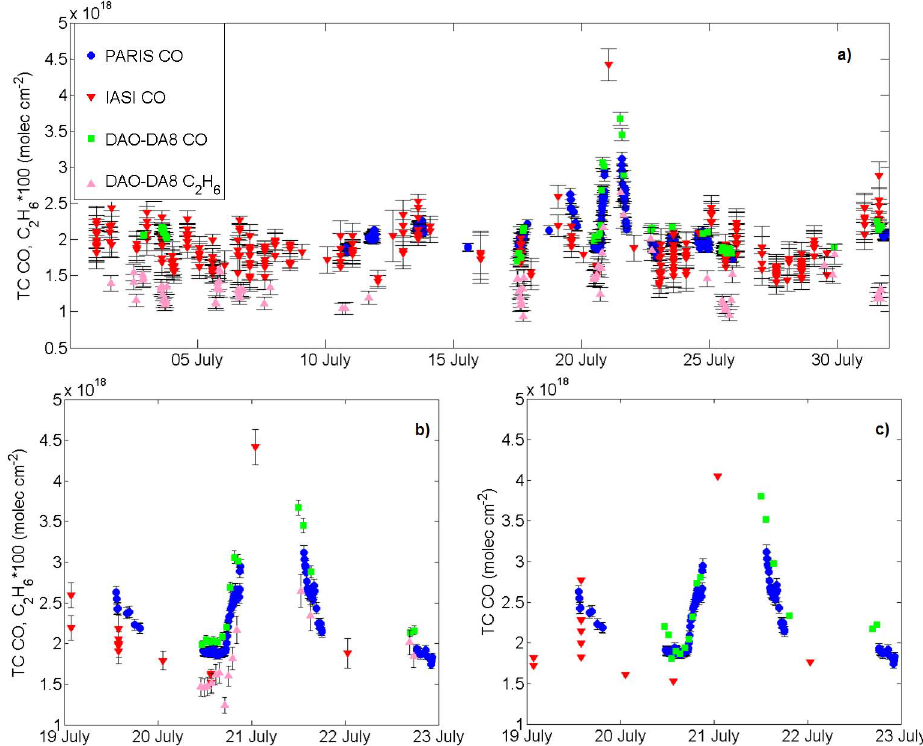
Fig. 2. The total column measurements (TC) in Halifax are shown for CO and C 2 H 6 for (a) July 2011, (b) between 19 and 23 July 2011, and (c) CO total columns of DAO-DA8 and IASI smoothed with the PARIS-IR averaging kernel. PARIS-IR (blue dots), IASI (red inverted triangles), DAO-DA8 (green squares) total columns for CO, and DAO-DA8 total columns for C 2 H 6 (pink triangles) are shown. The labels on the x axes indicate the start of each day at 00:00UTC. Note that the C 2 H 6 columns are scaled by a factor of 100 in panels (a) and (b) . The black bars indicate the estimated uncertainties for each gas and instrument, as described in Table 1 and Sect.